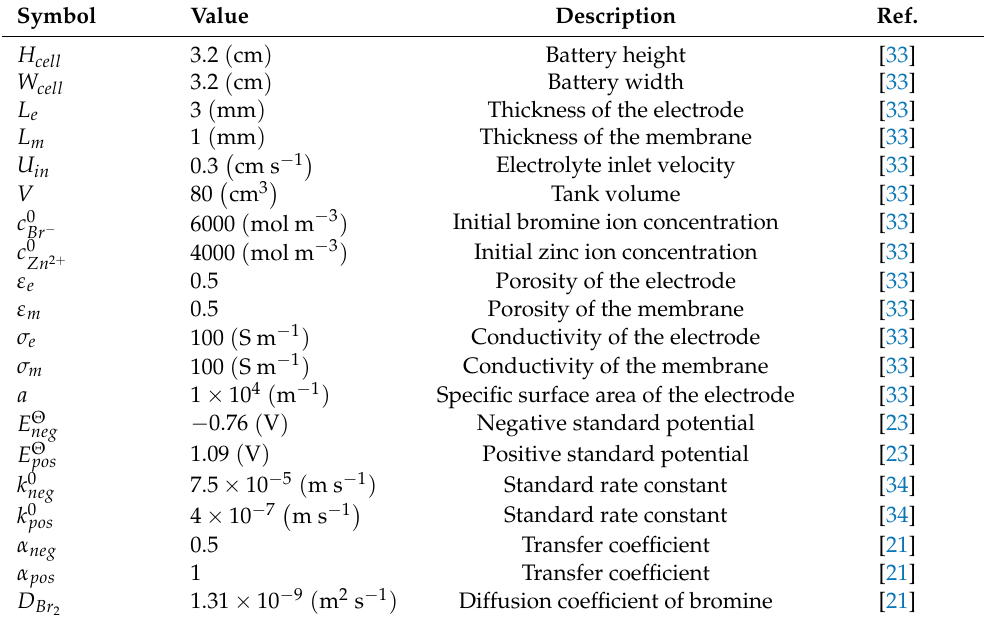
Table 3. Parameters and initial values used in the